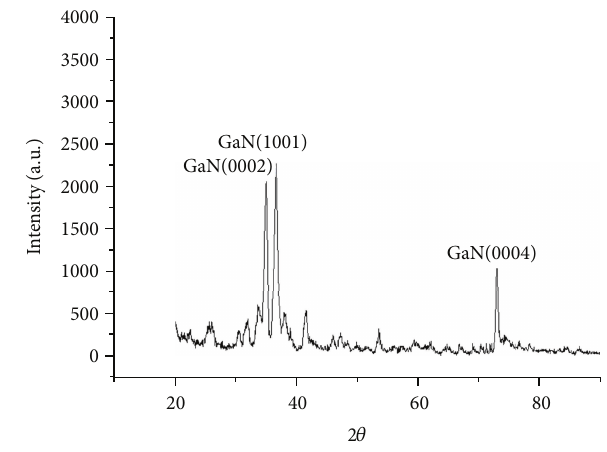
Figure 3: XRD pattern of GaN:Mn